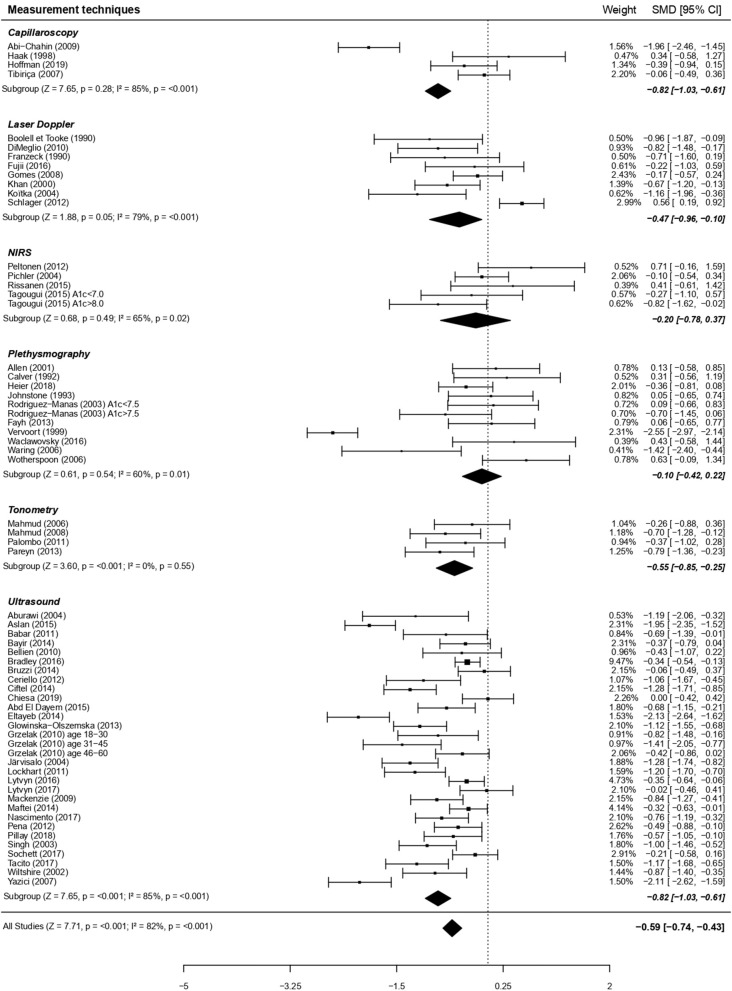
Forest plots of studies on endothelial function, according to measurement techniques, in subjects with type 1 diabetes vs. controls. For each subgroup, the following values are indicated: Z and p-value; I2, heterogeneity and p for heterogeneity. When comparing the six types of techniques with metaregressions (for qualitative data), the difference was significant (moderator P = 0.02), with a more visible dysfunction when using ultrasounds vs. plethysmography (post-hoc comparison using Bonferroni correction, P < 0.01).